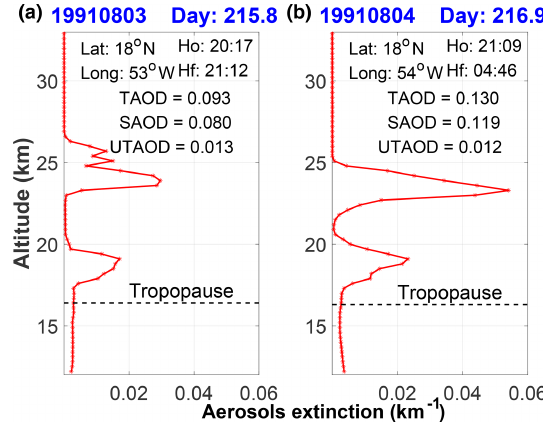
Figure 4. Profiles of the α aer ( z ) for 3 and 4 August at 18 ◦